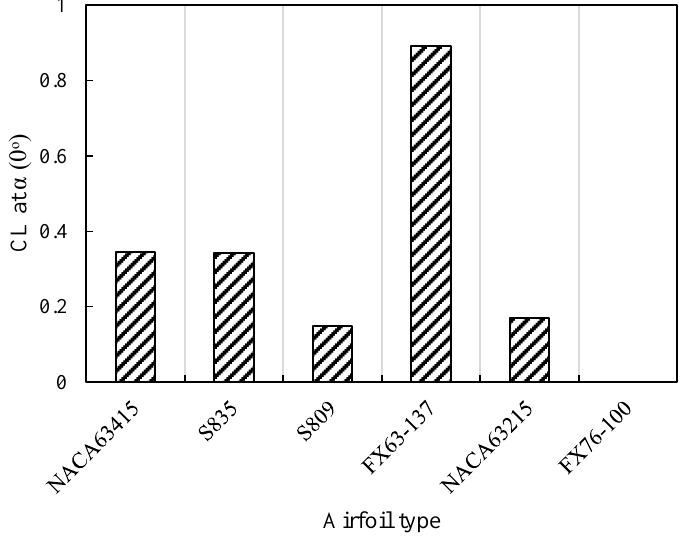
Figure 9. Lift coefficient at 0° angle of attack.